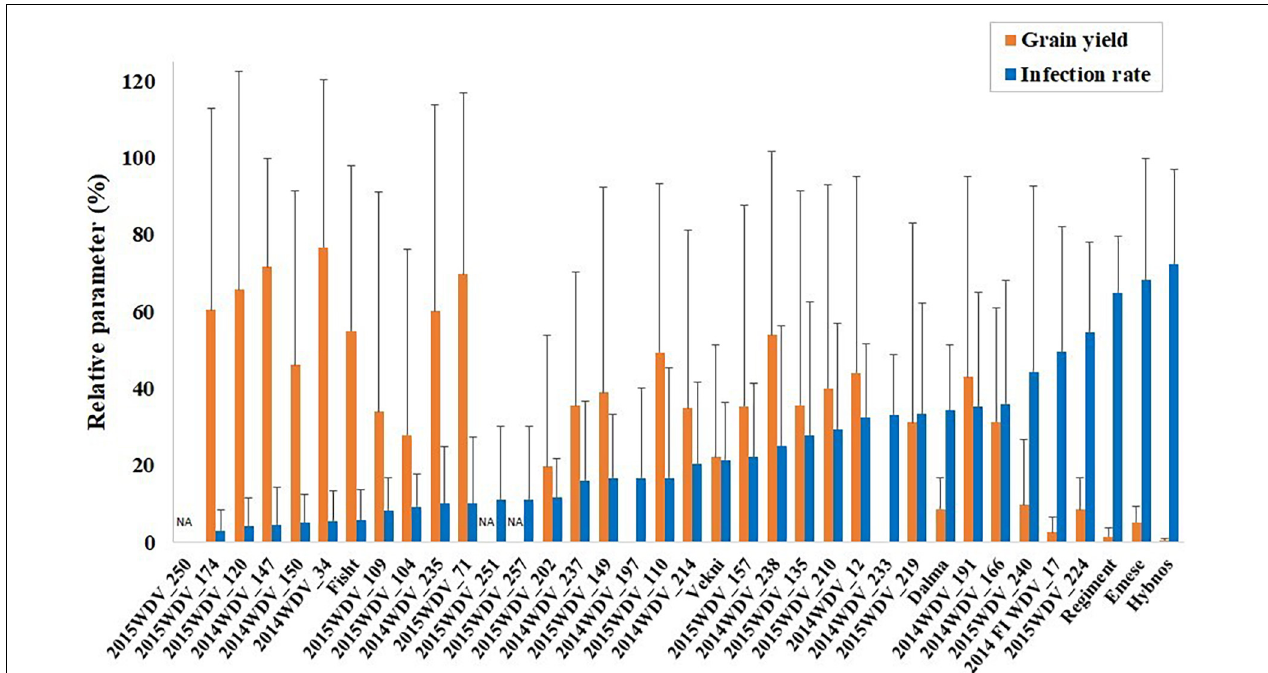
FIGURE 2 | Mean of infection rate (%) in May and relative grain yield (%) of the accessions tested in project year 1 + 2 + 3 or in project year 2 + 3, respectively, in comparison to the partially resistant varieties “Mv Dalma” and “Mv Vekni” and the susceptible varieties “Mv Regiment,” “Mv Emese,” and “Hybnos.” NA, yield not measurable due to spindle brittleness.